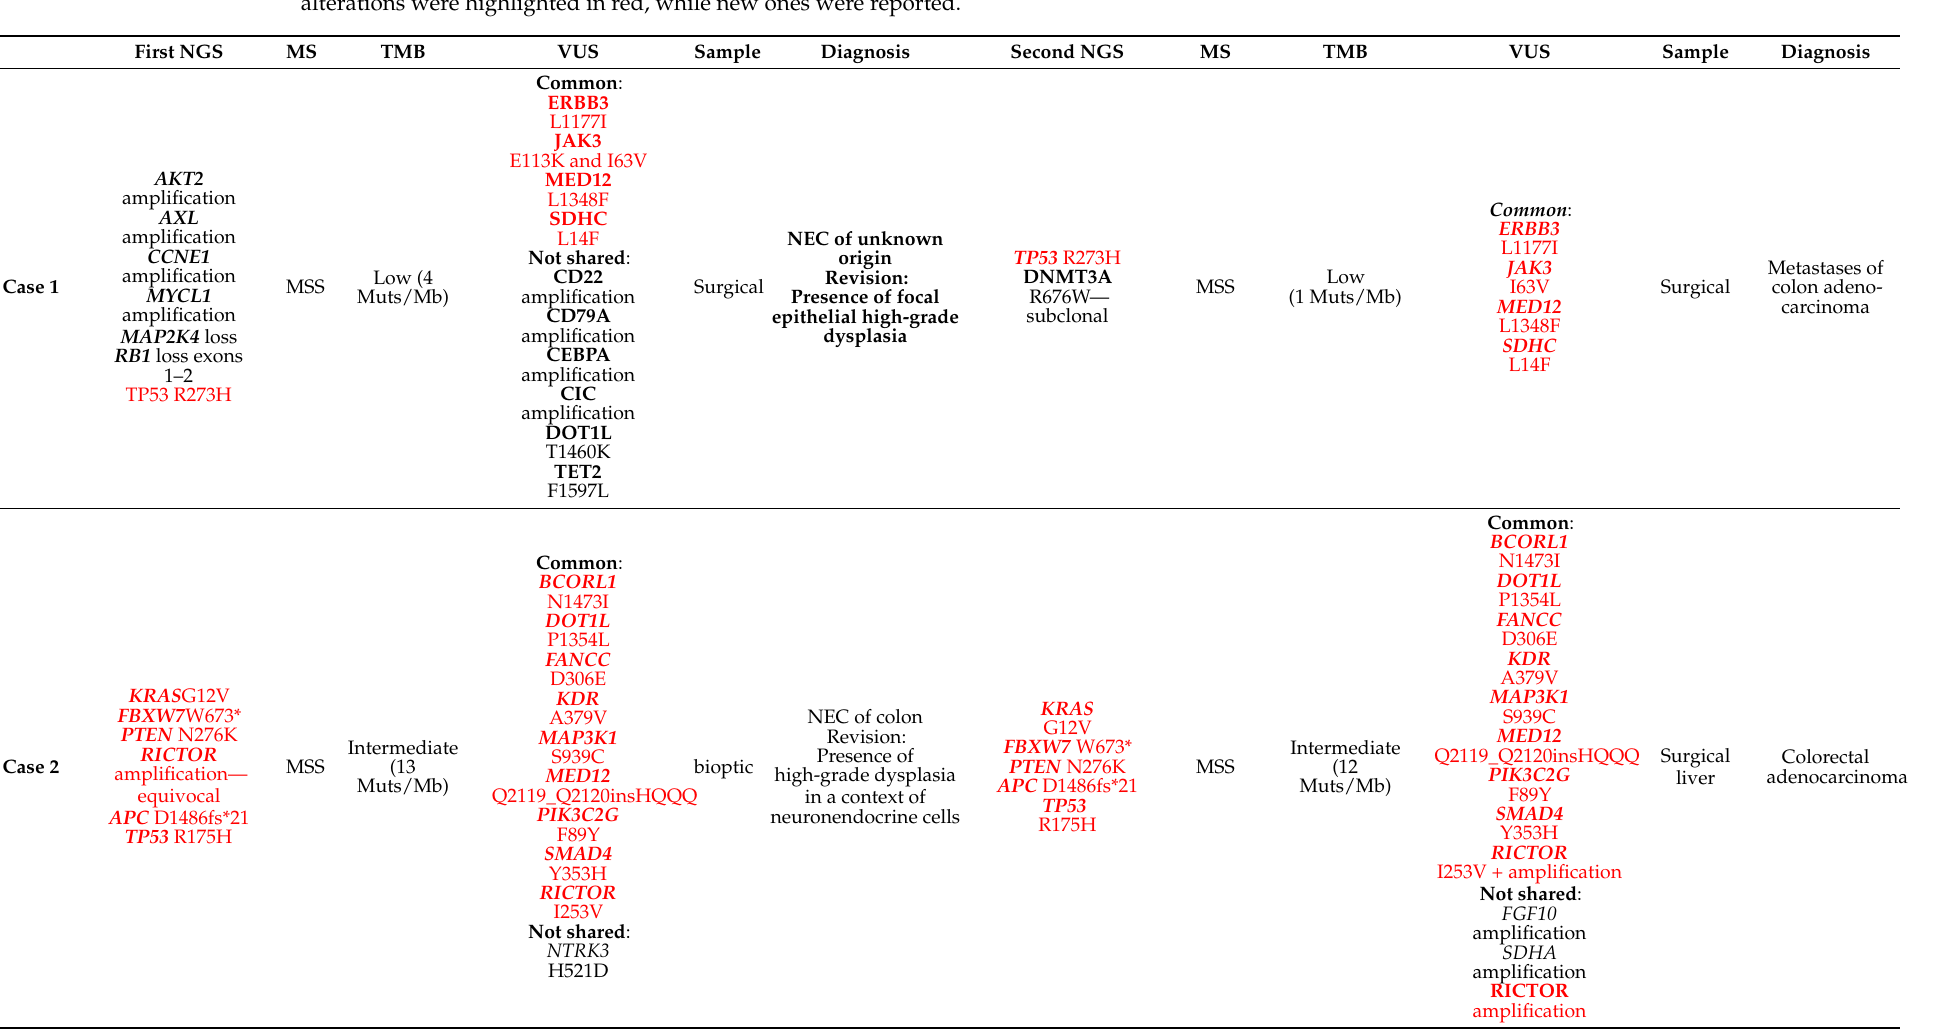
Table 2. Overview of the main alterations detected in the samples examined (surgical, bioptic, blood), at least two for each case except for Case 4. Comparison among samples collected at different times in the same patient was made in order to better understand disease evolution and the behavior of its counterparts: shared alterations were highlighted in red, while new ones were